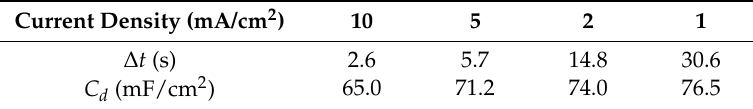
Table 4. Specific capacitances at various discharge current densities.